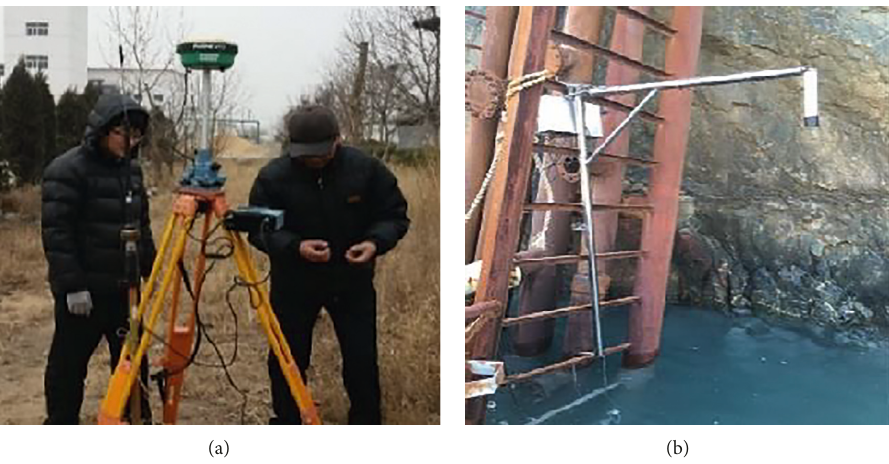
Figure 9: Monitoring equipment and monitoring points. (a) GPS monitoring. (b) Water level monitoring equipment.